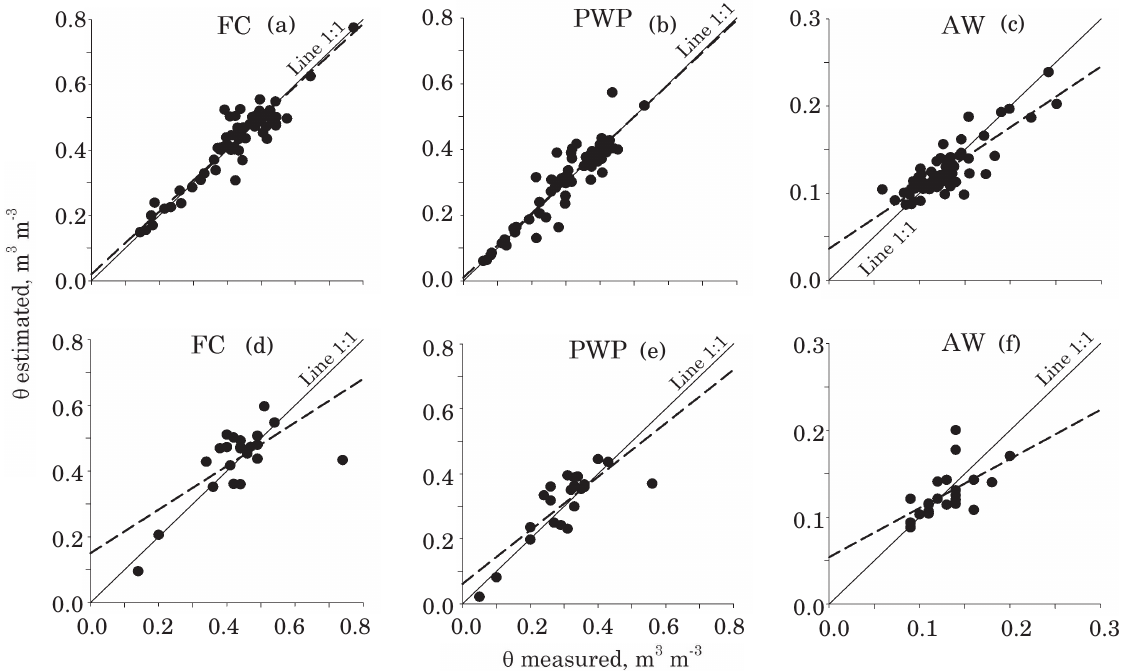
Figure 9. Field capacity (FC), permanent wilting point (PWP) and available water content (AW) measured and estimated by PTFs of the full model: five sand classes, silt, clay, organic matter, bulk density, particle density, total porosity and their interactions for the generation database (a, b, c) and validation database (d, e, f) for surface horizons of soils in the State of Santa Catarina.